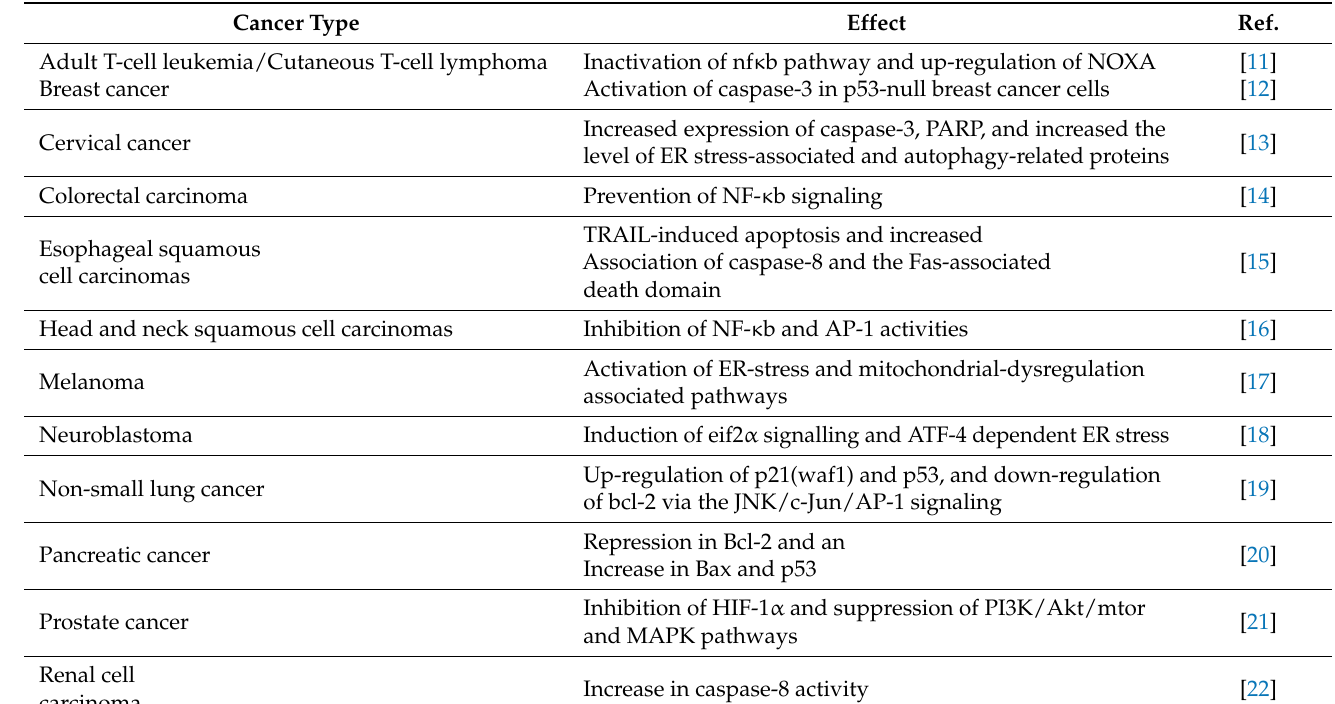
Table 1. The effects of Bortezomib on different